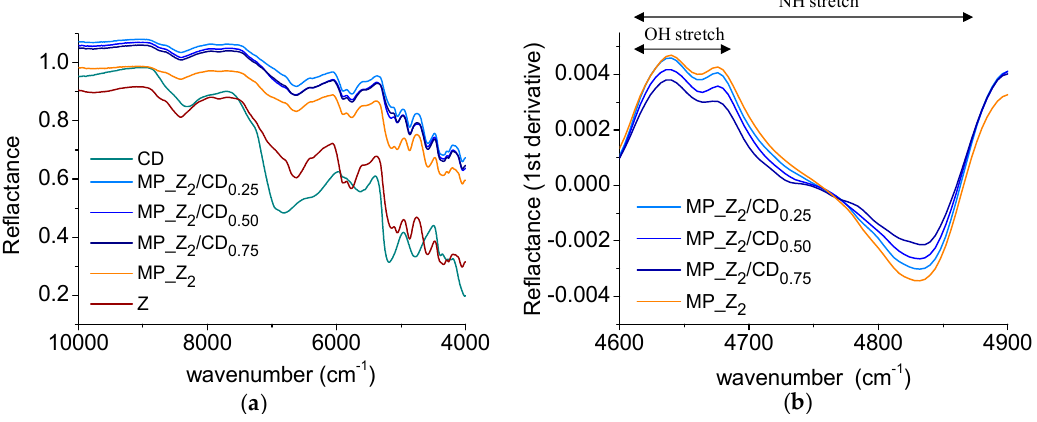
Figure 3. NIR spectra of zein and zein/CD micropowders. Reflectance ( a ) and first derivative spectra in the interval 4600–4900 cm − 1 ( b ).